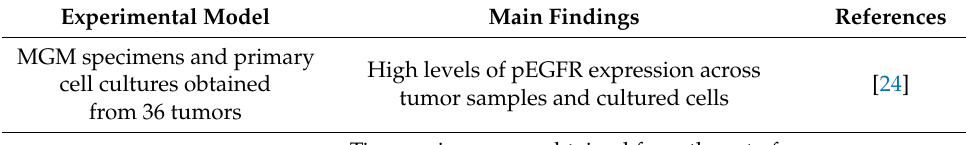
Table 2. Summary of selected studies presenting evidence for RTKs as biomarkers in